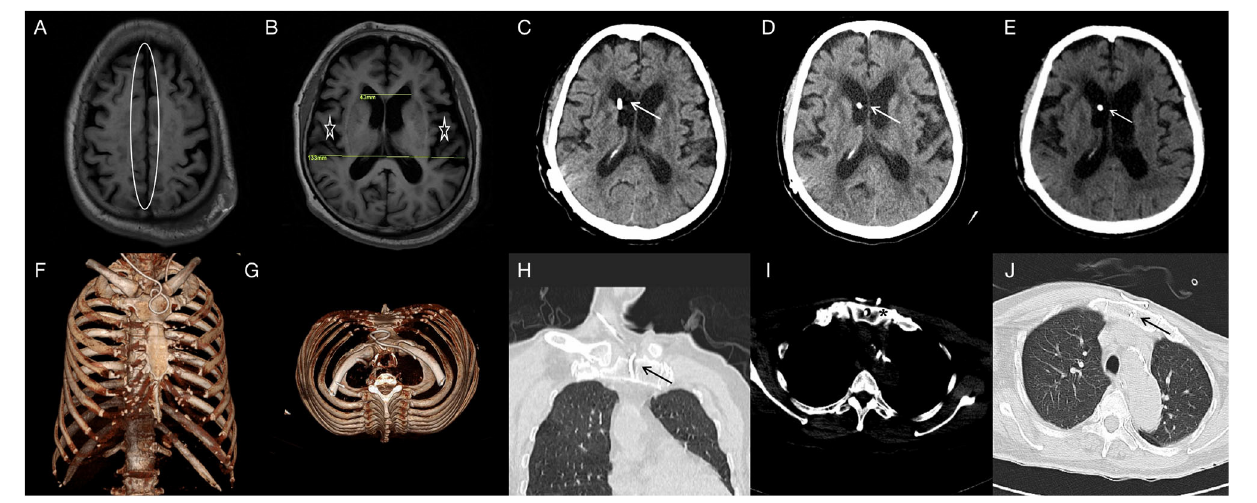
FIGURE 1 | T1FLAIR (A,B) brain MRI showing the narrowed sulcal spaces at the vertex (oval) and the enlarged ventricles of the brain and lateral cracks(asterisk) (DESH); Evans Index was 0.32. Two-month CT- (C) , 6-month CT- (D) and 16-month CT- (E) brain scan showing the catheter in position and the hydrocephalus is relieved . One-week three-dimensional reconstructed CT- (F,G) scan of the thorax showing the distal catheter in situ . Two-month CT- (H,I) and 16-month CT- (J) thorax scan showing the sternum is intact and the distal catheter in situ